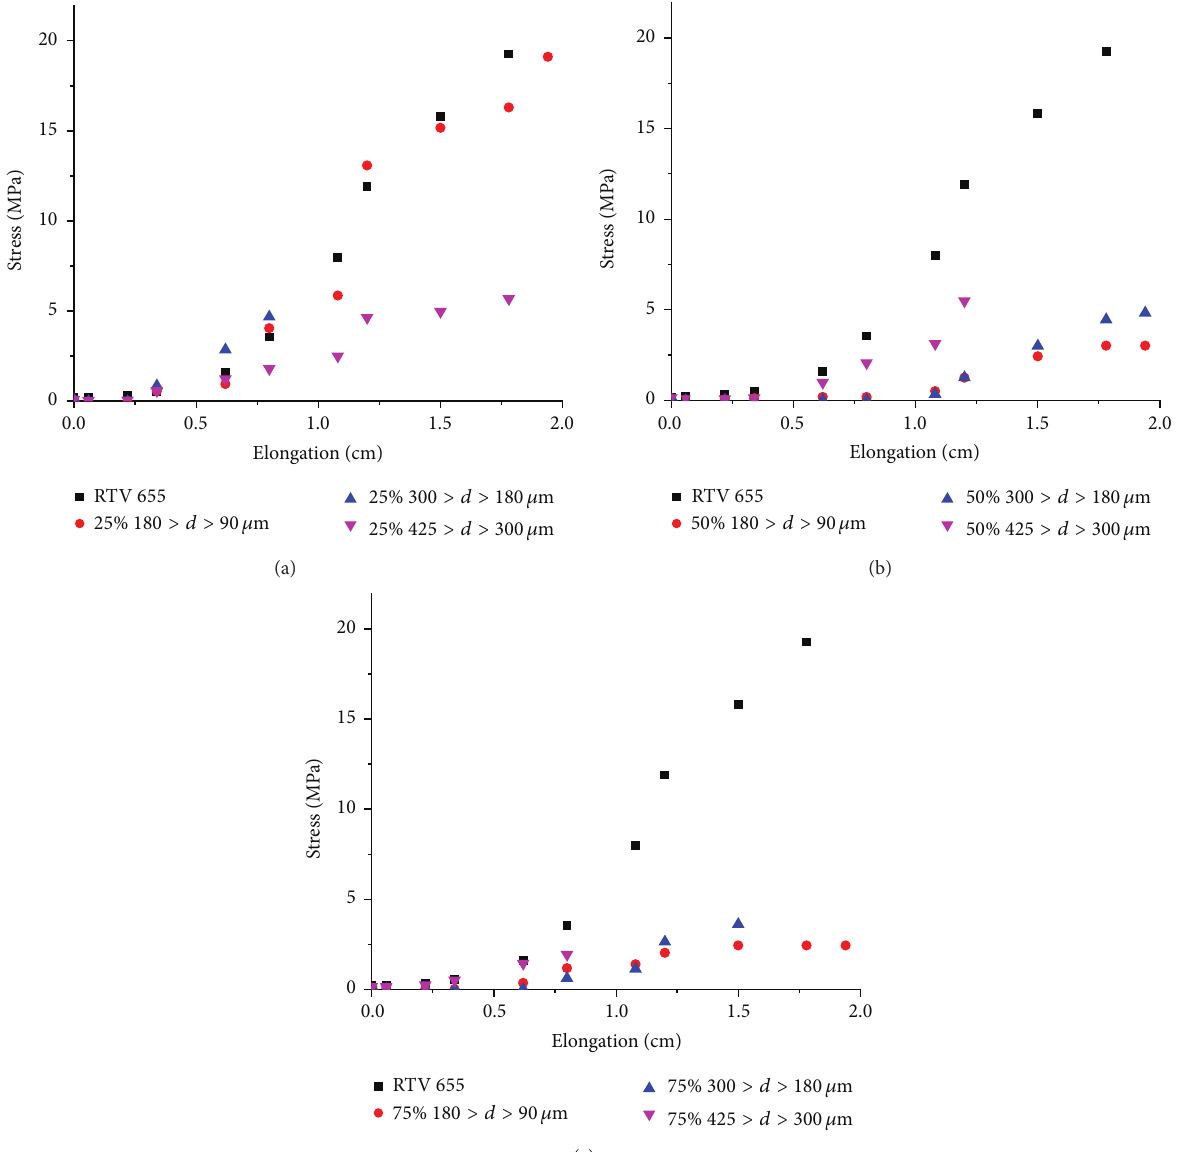
Figure 8: Effect of PCSA particle size and concentration on the stress-elongation behavior of the compound material at 77 K. As IL increases from25%(a)to50%(b)andfinally75%,(c)thecompoundmaterialbecomesweakerrupturingunderlowerloadvaluesthantheneatpolymer. Effect of the particle size variation seems less significant than the